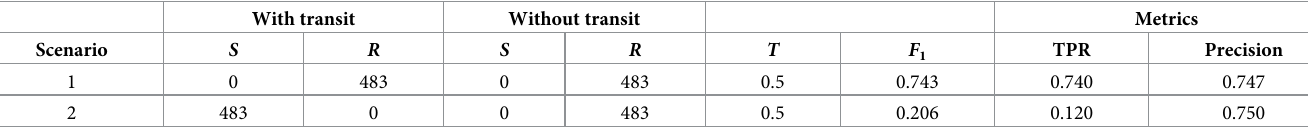
Table 3. Detection performance under proposed